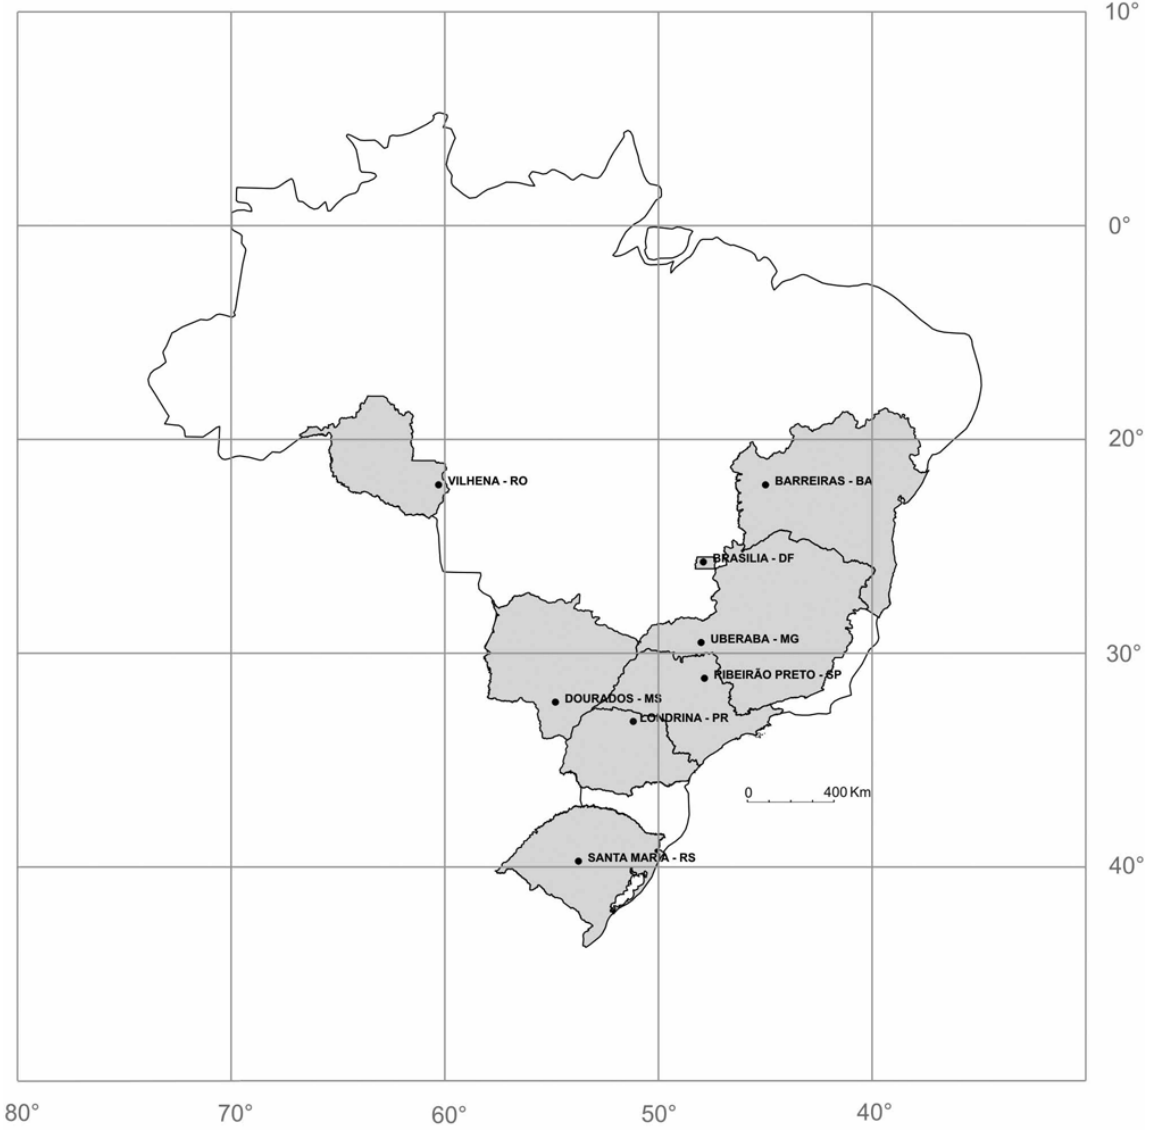
Fig. 3 – Map with the geographical distances among the populations of Chlosyne lacinia saundersii . Was based on the coordinates of each collection site and expressed in kilometers through the software GPS TrackMaker r 13.4 (http://www.gpstm.com/).